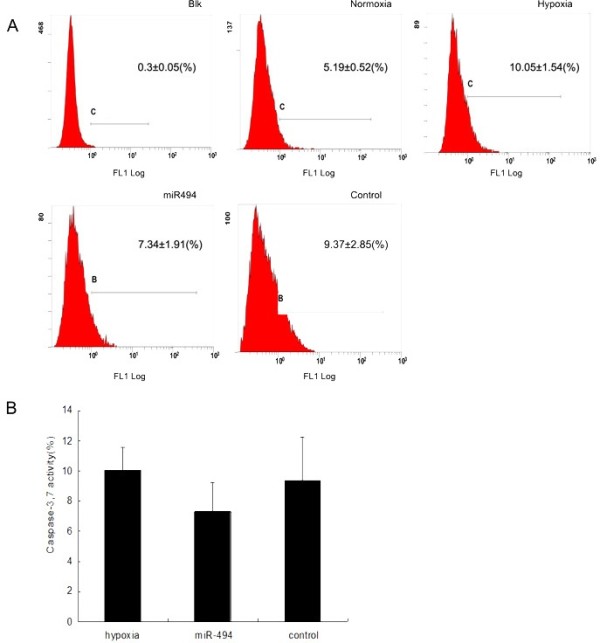
Caspase-3 and caspase-7 activity in transfected cells under hypoxia. Transfected cells were incubated under hypoxia for 8 hours. Cells were harvested and Caspase-3/7 activity were determined using the Caspase-3 and Caspase-7 Assay Kit by flow cytometry. (A) Flow cytometry results for caspase-3/7 activity. (B) Histogram of the percentage of caspase-3/7 activity among different groups. Control indicated miR-negative control. The data were presented as the means ± SD. Columns, mean of three independent experiments; bars, SD.